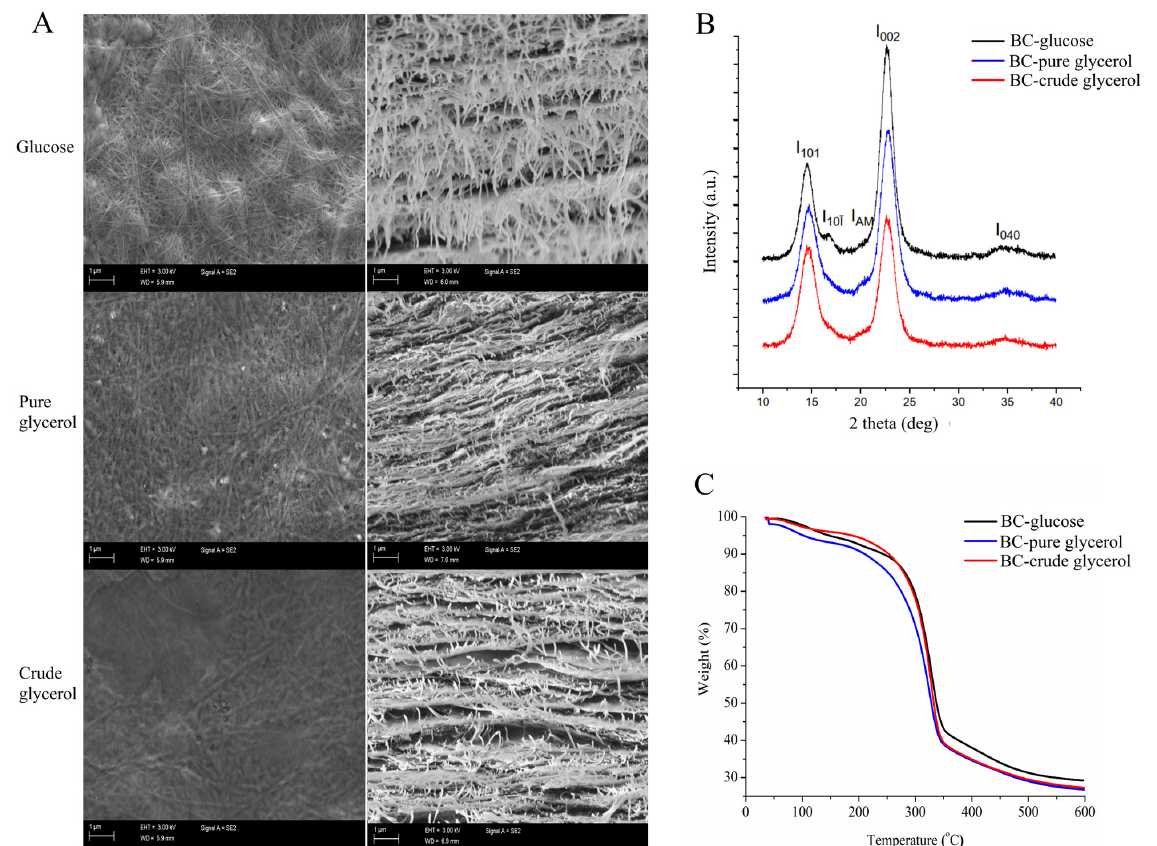
Figure 3. BC film characterization. ( A ) Scanning electron microscopy (SEM) surface and cross-sectional images, ( B ) X-ray diffraction (XRD) diffractograms and ( C ) thermogravimetric analysis (TGA) of BC films synthesized from MA/9 medium containing 2% glucose (BC—glucose), pure glycerol (BC—pure glycerol) and crude glycerol (BC—crude glycerol). The diffraction peaks subfigure ( B ) at I101 and I10¯ı, I002 and I040, and IAM represents the crystalline I α , I β and amorphous